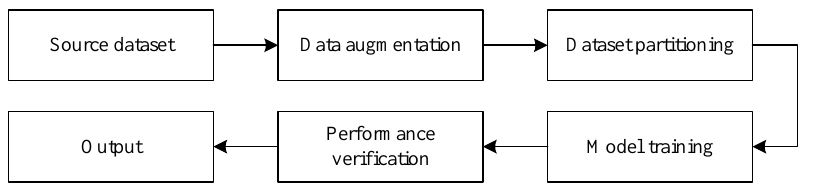
Figure 5. Overall flow of the proposed